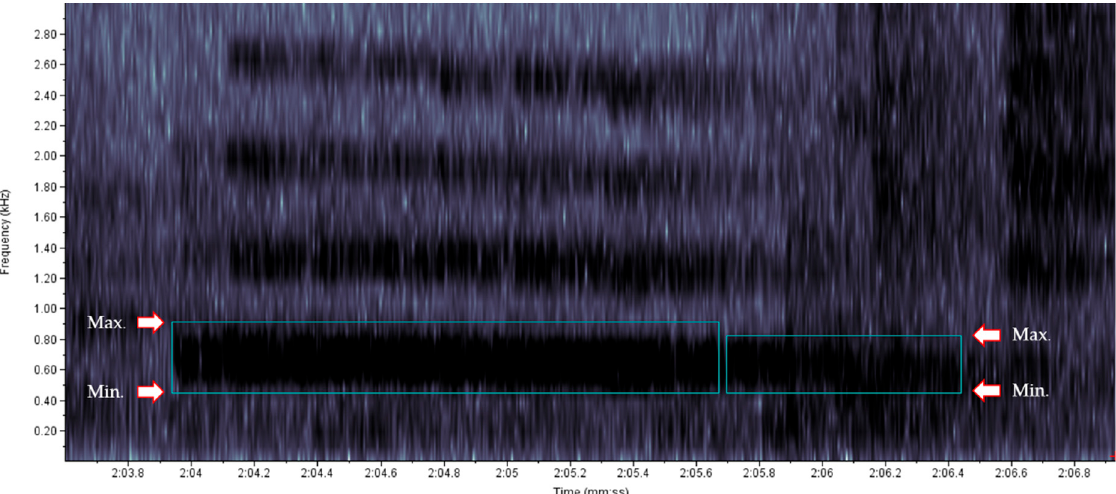
Figure 1. Illustrative spectrogram of a trainer’s speech. Blue boxes represent the marking of the fundamental frequency (F0) of two distinct speech events. Arrows indicate the maximum (max.) and minimum (min.) frequencies of these speeches. X axis: time interval (200 ms); y axis: frequency in kHz. Table 2. Description of seven types of trainer vocalization, obtained for each training session with socialized dogs ( Canis familiaris ) and wolves ( Canis lupus